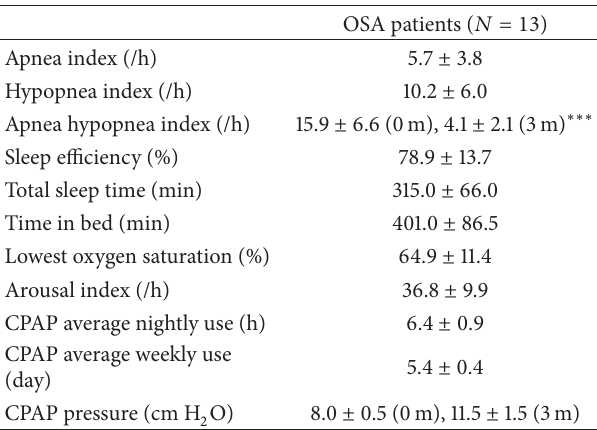
Table 2: Polysomnographic data prior to CPAP therapy in OSA